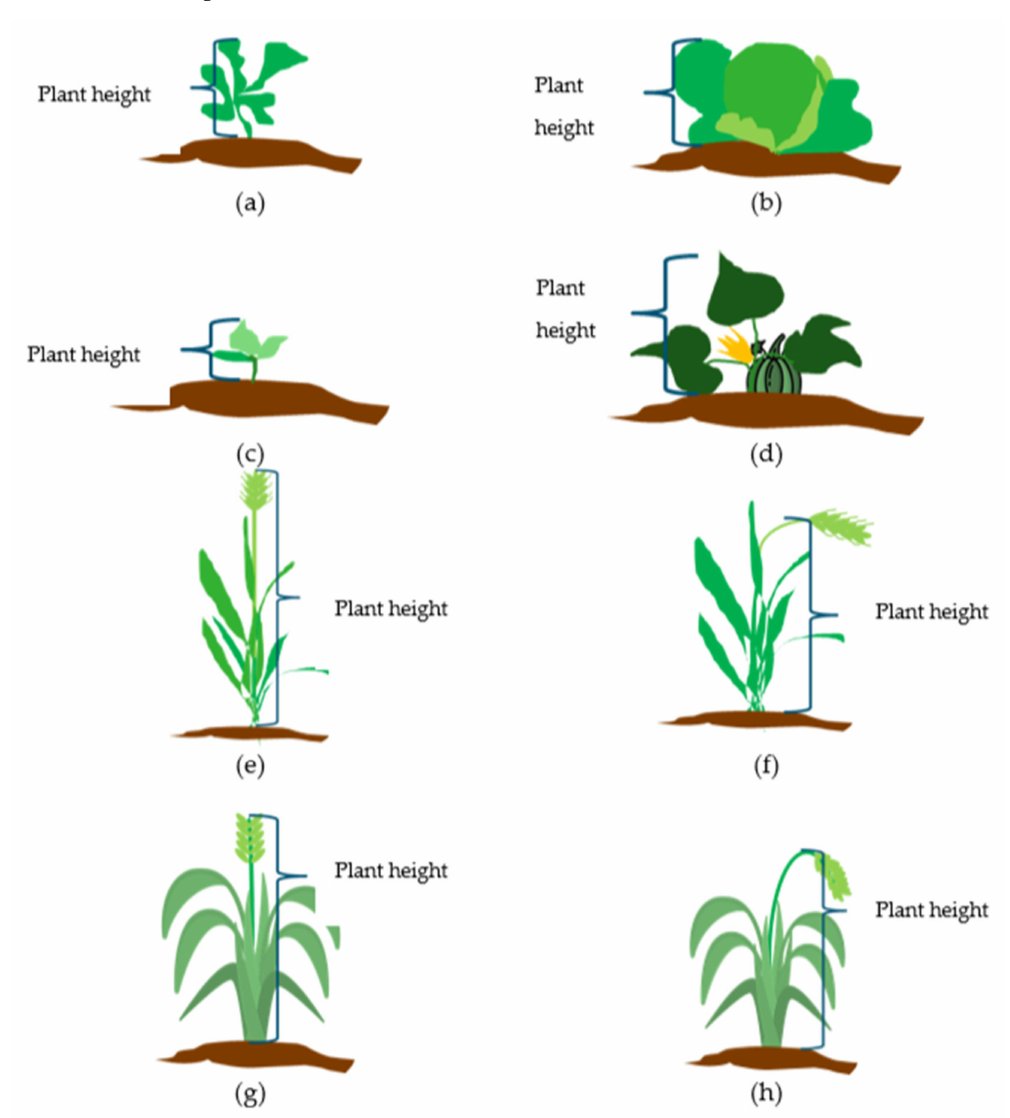
Figure 2. Plant height measurements according to growth stages for cabbage ( a , b ); pumpkin ( c , d ); barley ( e , f ); wheat ( g , h